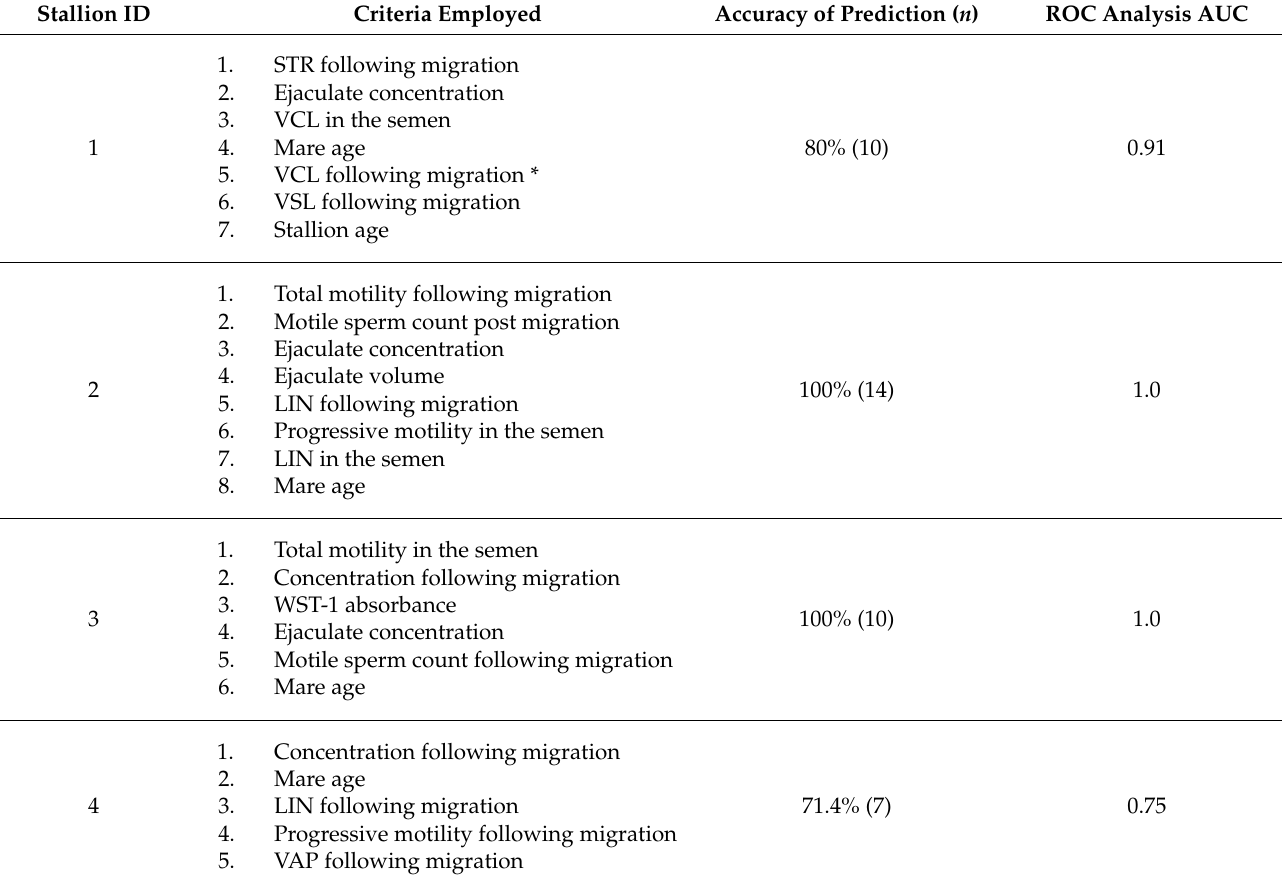
Table 2. Criteria employed to predict the success of insemination by stallion (analysis performed on semen prior to